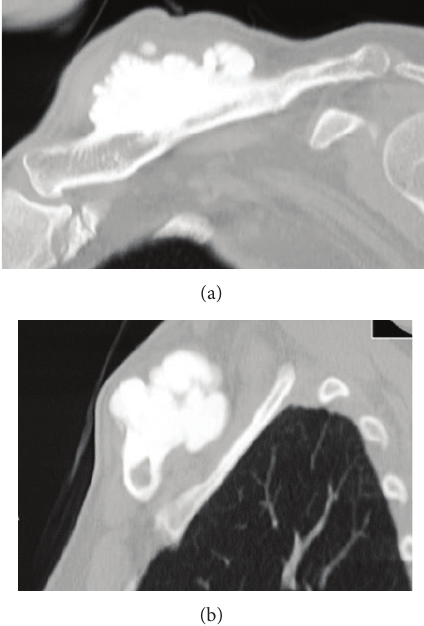
Figure 2: Computed tomography scan reveals that the heavily ossified mass is attached to the cortex and has no areas of lucency. The cortex underlying the osteoma is intact. (a) Coronal image of the left clavicle; (b) sagittal image of the left clavicle.